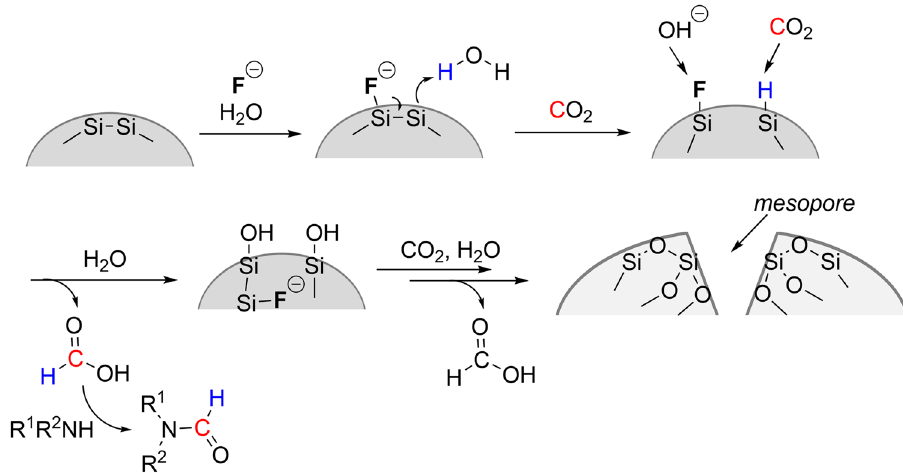
Fig. 7 Schematic image of proposed reaction mechanism. Fluoride-catalyzed reduction of CO 2 occrs at surface and inside bluk of silicon particle.